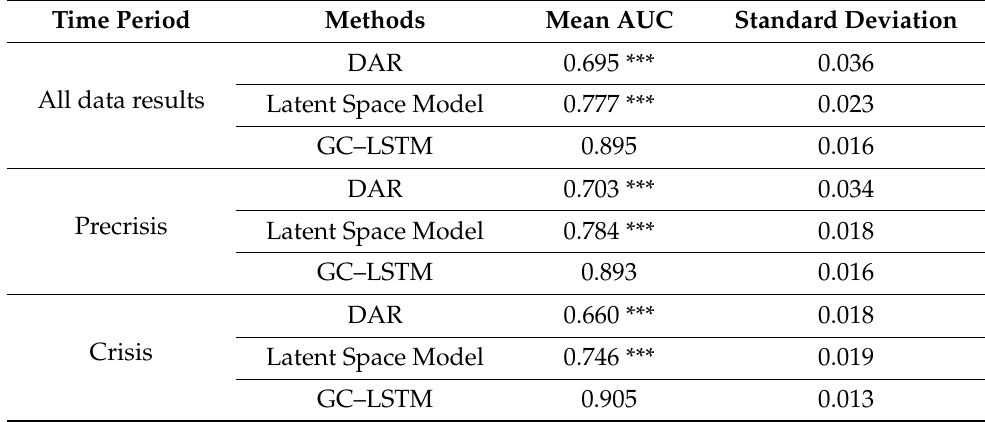
Table 3. AUC score for three models in the top 100 Italian banks. The significance level of 1% (***) is used to assess the mean difference between the benchmark models (DAR or Latent space model) and the GC–LSTM model with the t